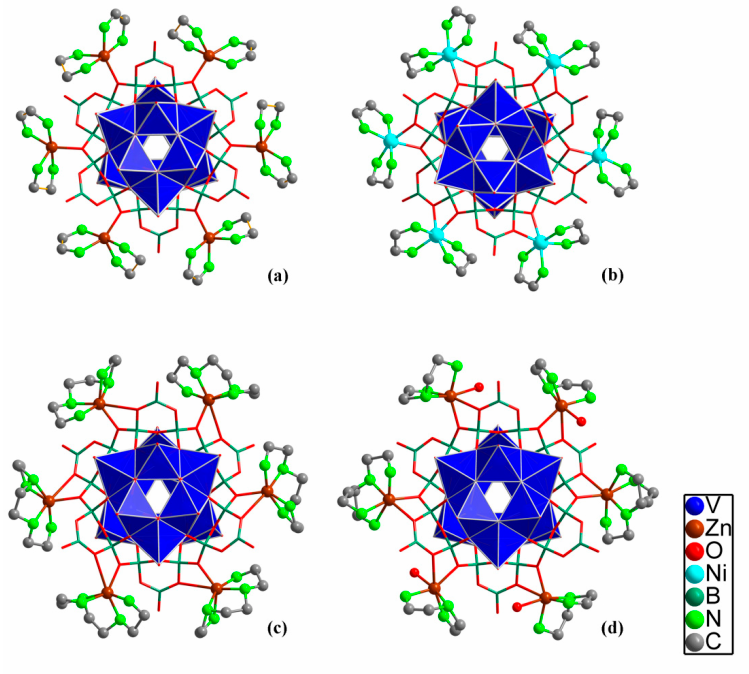
Figure 4. The [V 12 B 18 O 60 ] core with the complexes: ( a ) Zn(en) 22+ for ( 6 ), ( b ) Ni(en) 22+ for ( 8 ), ( c ) Zn(teta) 2+ for ( 9 ), and ( d ) Zn(dien) 2+ and [Zn(dien)(H 2 O)] 2+ for ( 10 ). Complexes Cu(en) 22+ , [Cu(dien)(H 2 O)] 2+ , and Zn(H 2 teta) 22+ are part of the crystalline lattices of ( 7 ), ( 11 ), and ( 13 ), respectively, each of them coordinated to the [V 12 B 18 O 60 ] clusters. However, in these lattices